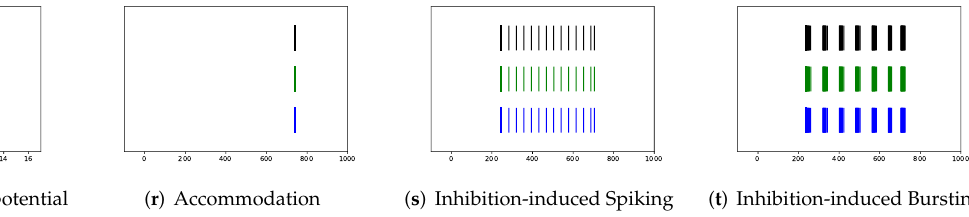
Figure 10. Spike trains of Izhikevich model (black) vs. unmodified RCR (green) vs. modified RCR by maximum tolerance (blue), where x-axis is the time (ms).